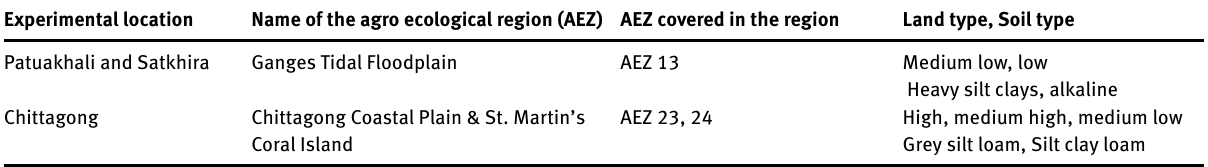
Table 1: Agro-ecological zone, land type and soil type of the experimental sites Experimental